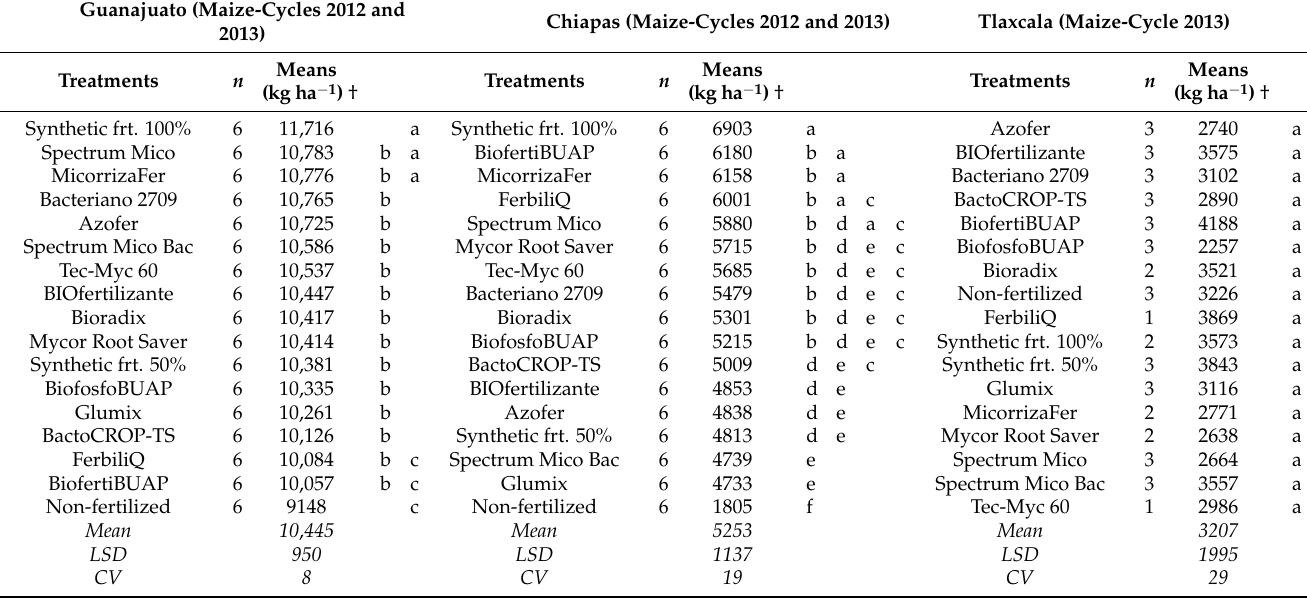
Table 8. Means comparisons of experiments conducted in three Mexican states during 2012 and 2013 (Group 1) to test the effectiveness of partially substituting synthetic fertilizers by biofertilizers.